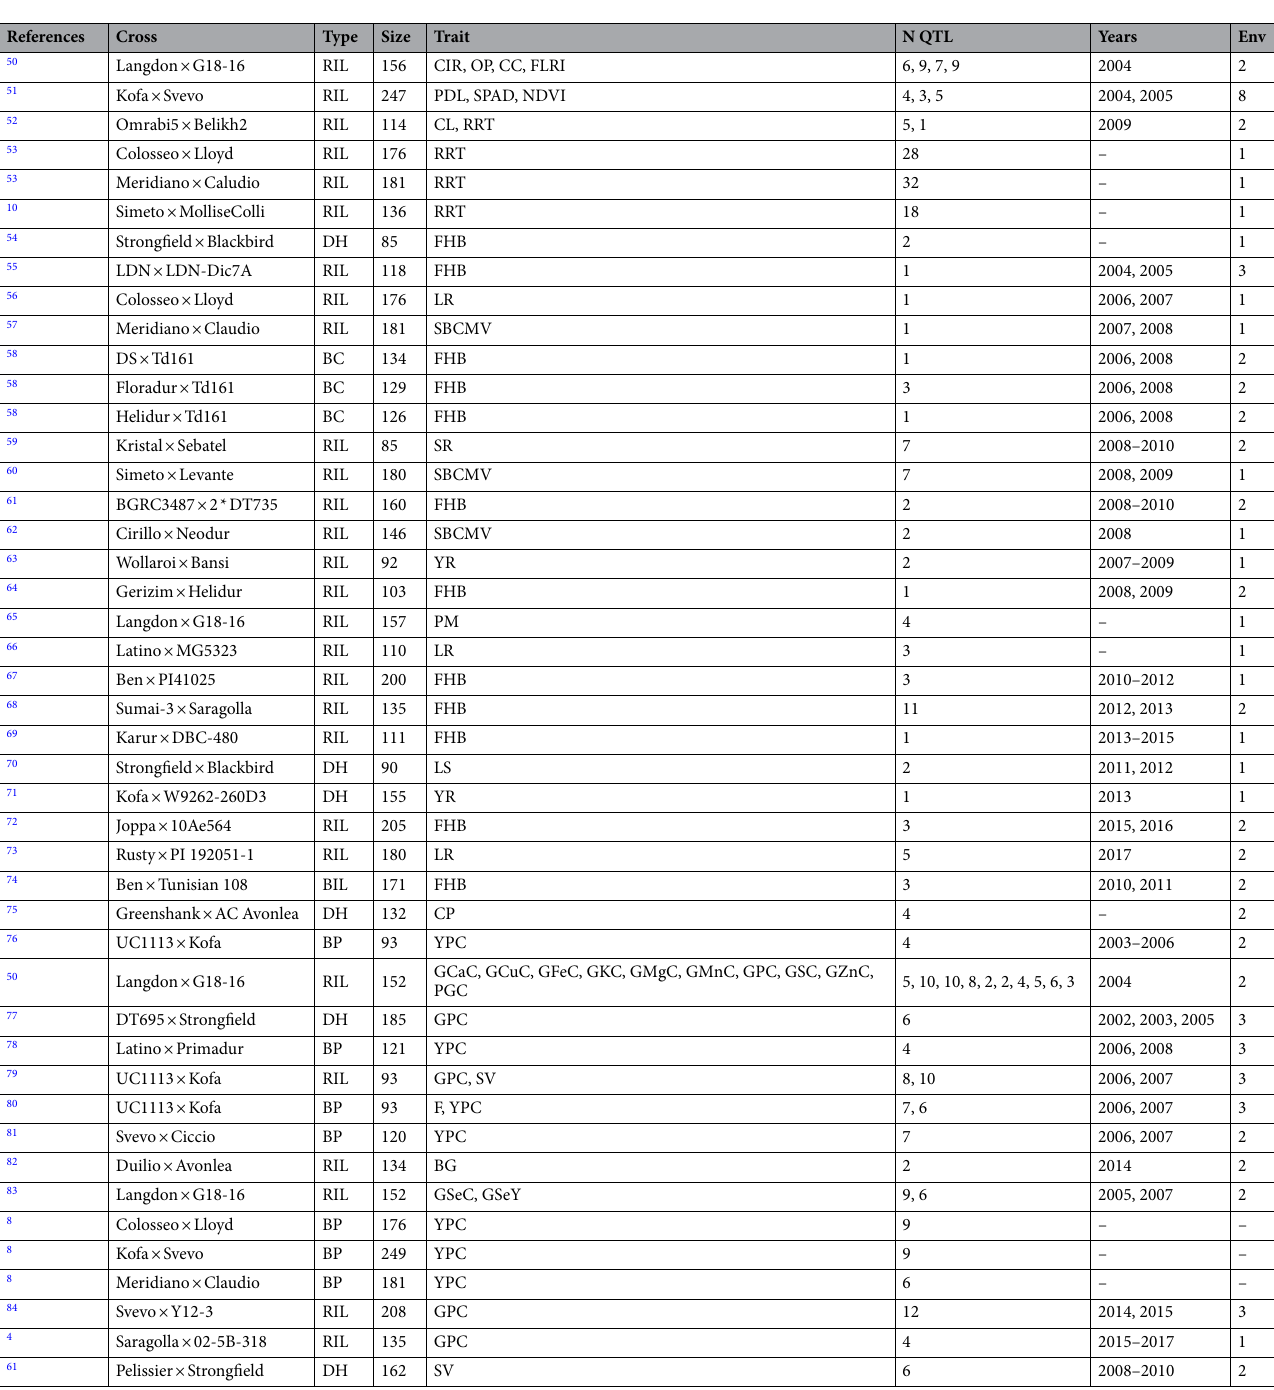
Table 2. Mapping populations used in the study and related references, including the years when experiments were done and the number of environments